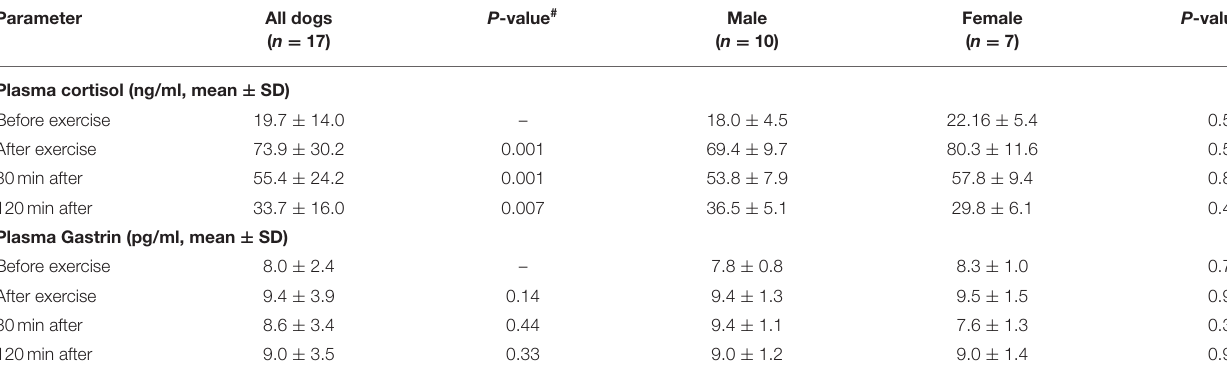
TABLE 1 | Plasma cortisol and plasma Gastrin levels of the pilot study. Parameter